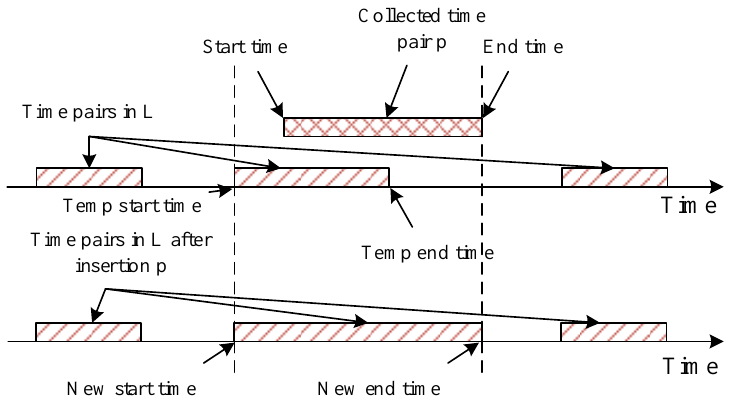
Figure 4. An illustrative diagram to time pair insertion.